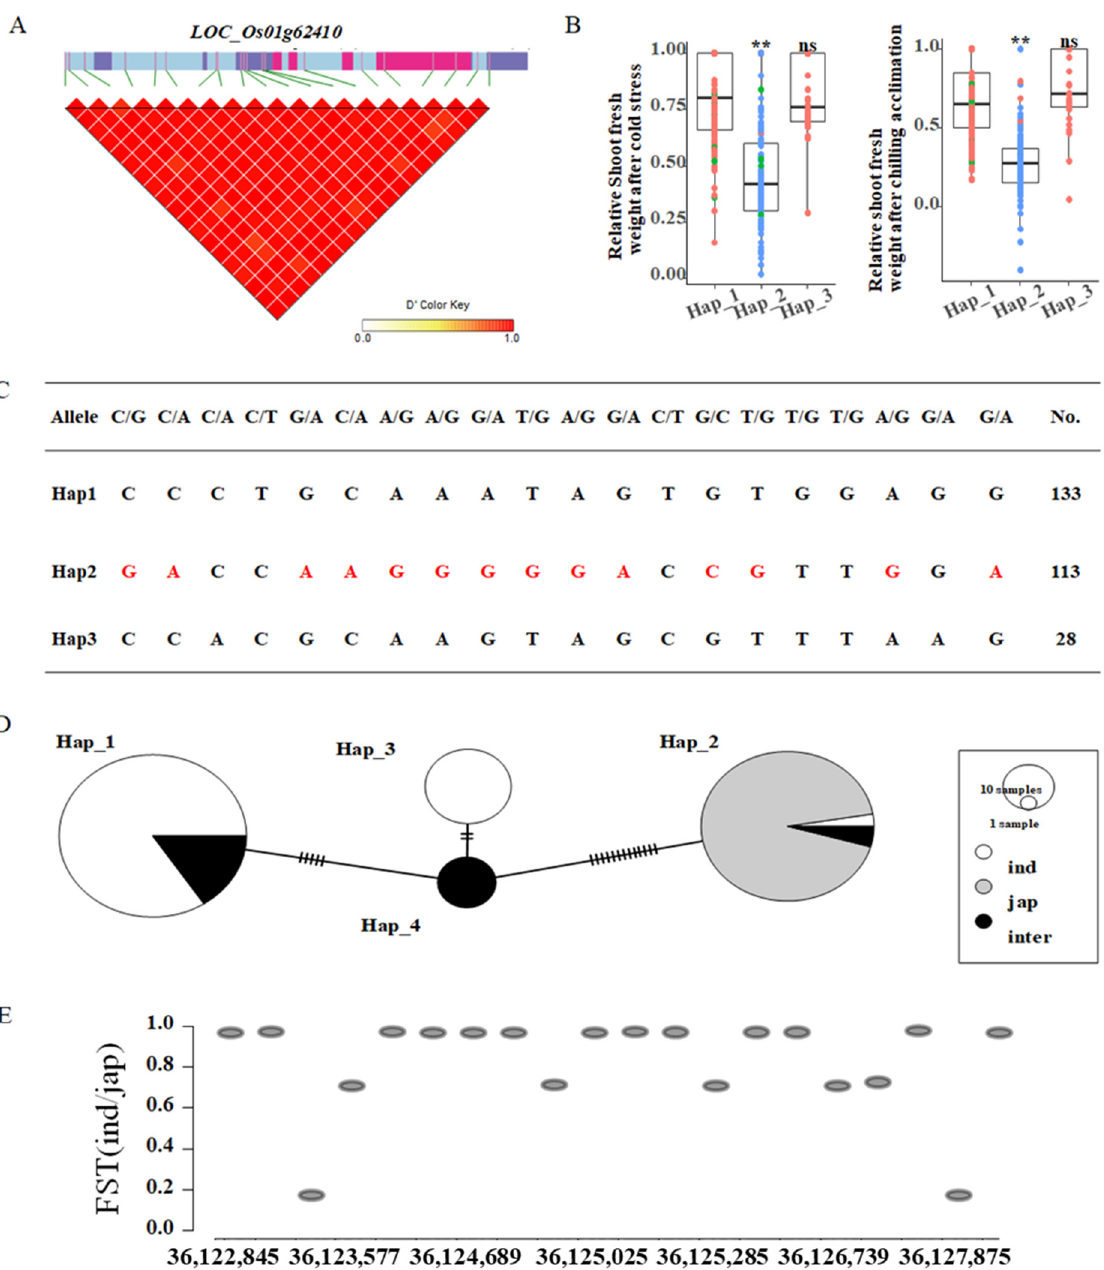
Figure 5. LD block, haplotype, and distribution analyses of the SNPs. ( A ) LD block analysis of LOC_Os01g62410 . ( B ) Haplotype analysis of LOC_Os01g62410 under cold stress and chilling acclimation. ( C ) SNPs information of each haplotype. ( D ) Haplotype network of LOC_Os01g62410 and color represents different rice subpopulations. White represents indica accessions, gray represents japonica accessions, and black represents intermediate accessions. ( E ) FST analysis of LOC_Os01g62410 between indica and japonica subpopulation. FST was calculated between indica and japonica accessions. A, color represents different rice subpopulations. Red represents indica accessions, blue represents japonica accessions, and the green represents intermediate accessions. ** represent significant differences at 0.01 levels.